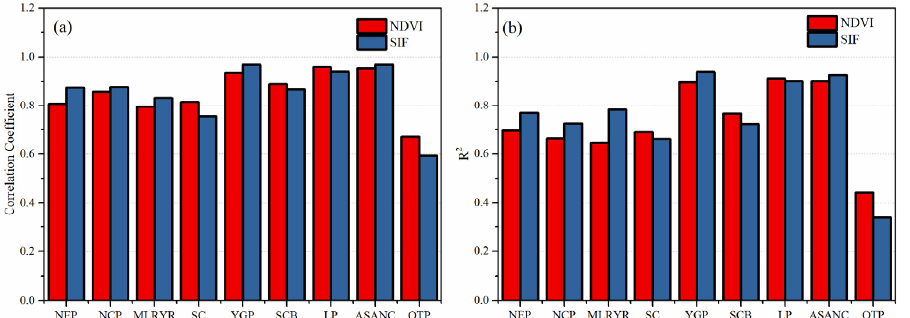
Figure 6. ( a ) PCC values and ( b ) R 2 values obtained between SIF (NDVI) and the per-unit grain yield during the growing season over different subregions. during the growing season over different